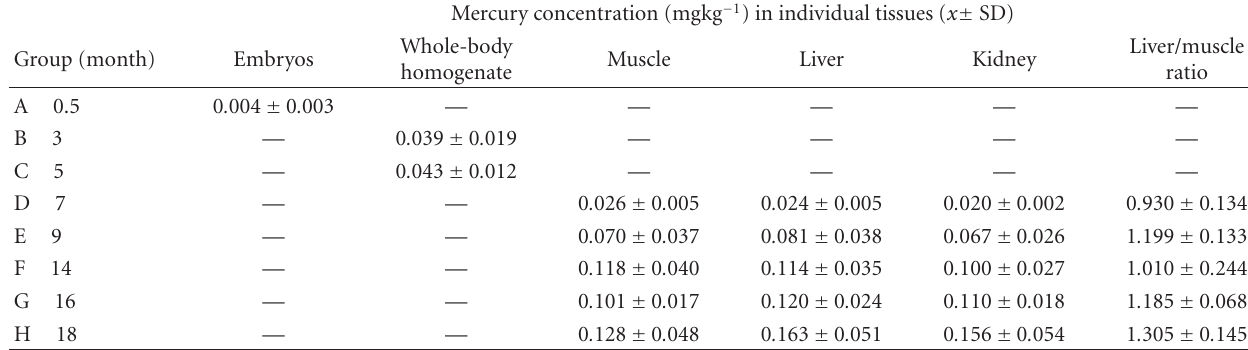
Table 4: Total mercury concentrations found in individual tissues investigated.